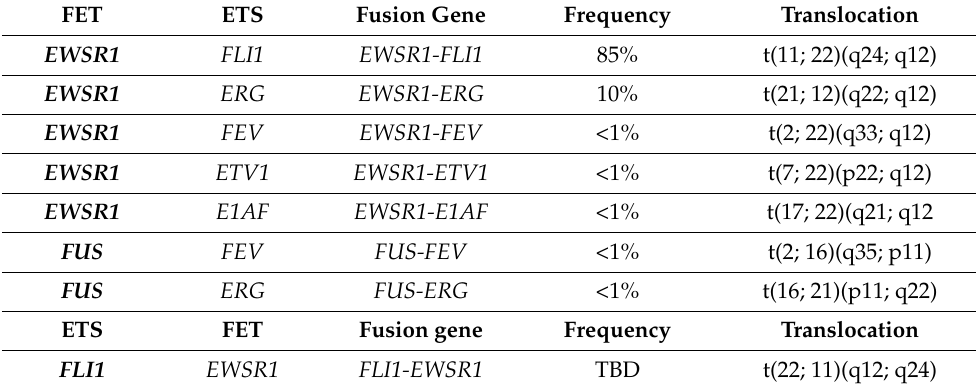
Table 1. A summary of FET–ETS fusion oncogenes in Ewing